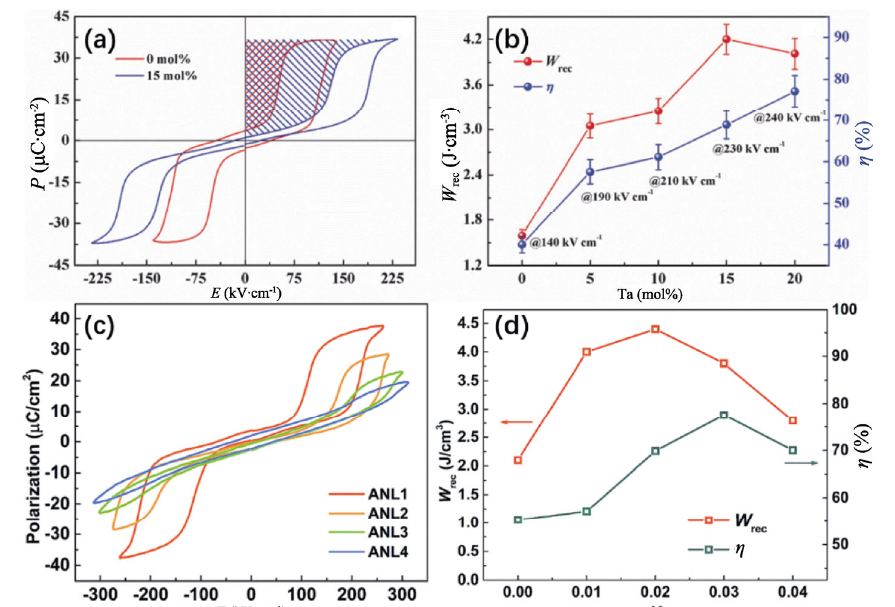
Fig. 12 P – E loops and energy-storage properties at room temperature of (a, b) ANT [83] and (c, d) ANL [84] ceramics. Reproduced with permission from Ref. [83], © WILEY-VCH Verlag GmbH & Co. KGaA, Weinheim 2017; Ref. [84], © The Royal Society of Chemistry